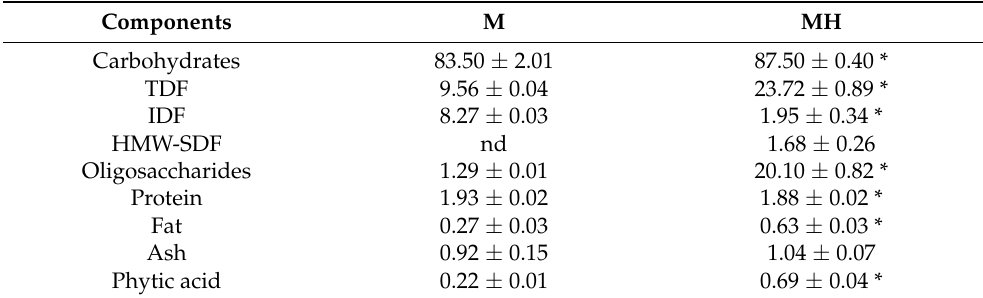
Table 1. Nutritional composition (g/100 g dw) of control mousse (M) and mousse with HYD (MH).